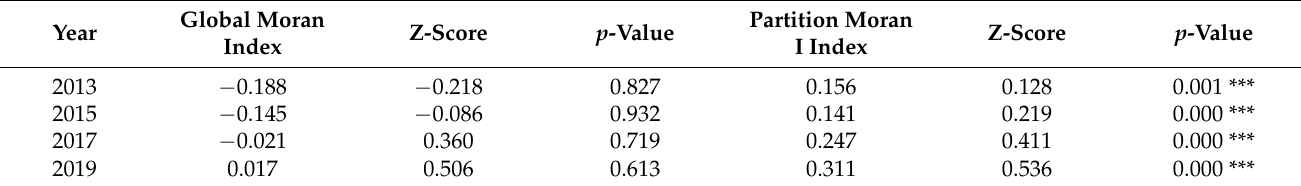
Table 4. Global Moran index and test results.